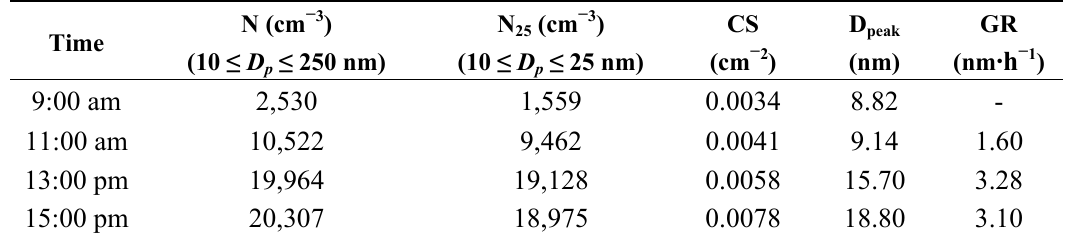
Table 1. Total number concentrations of fine mode (N) and nucleation mode (N ), condensation sink (CS), and particle growth rate (GR) particles, peak diameter ( D peak during the 4 March 2006 nucleation